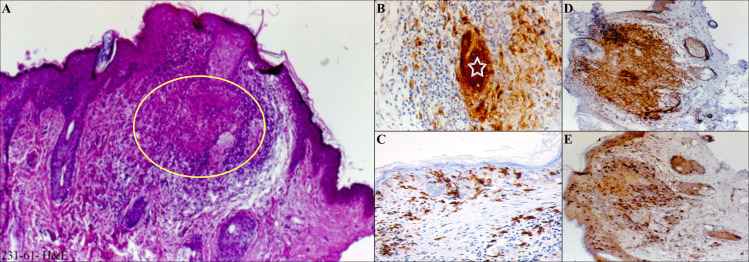
Histopathological and immunohistochemical findings in relapse (lupoid) form.A) H & E staining shows histopathological changes of thin epidermis and non-caseating epithelioid granuloma (empty circle) in the dermis, B) aggregation of histiocytes and Langhans giant cell by CD68 IHC staining (empty star), C) S100 and E) CD1a, network lattice like collection of Langerhans cells in epidermis and dermis and even in the granuloma, D) CD3, T-lymphocytes infiltrate between the histiocytes.